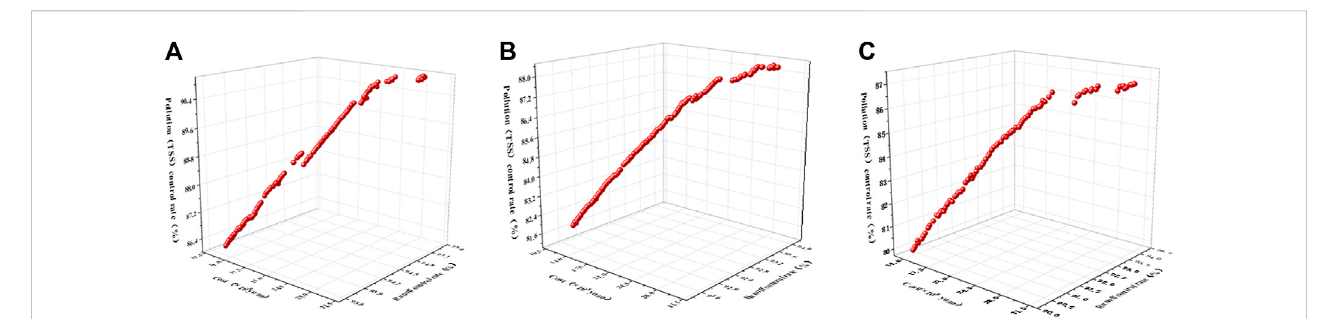
FIGURE 8 The Pareto Front solutions under three different periods [ (A) T = 2-year; (B) T = 5-year; (C) T =